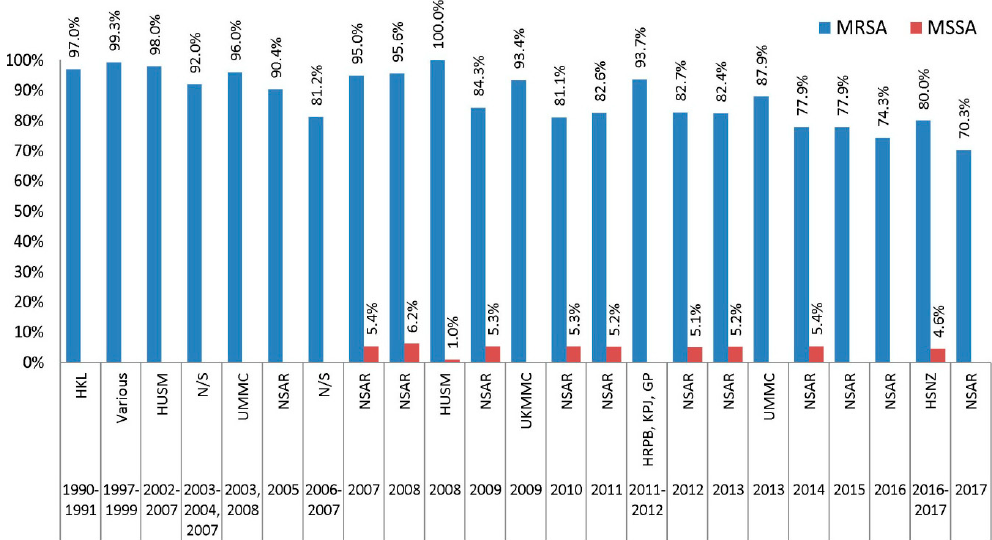
Figure 2. The prevalence of amikacin and netilmicin resistance among Malaysian MRSA isolates, 1990–2008. Data from the NSAR reports; HKL between 1990 and 1991 [13]; not specified (N/S) between 2003 and 2004 and in 2007 [16], and between 2006 and 2007 [17]; and UMMC in 2003 and 2008 [18].